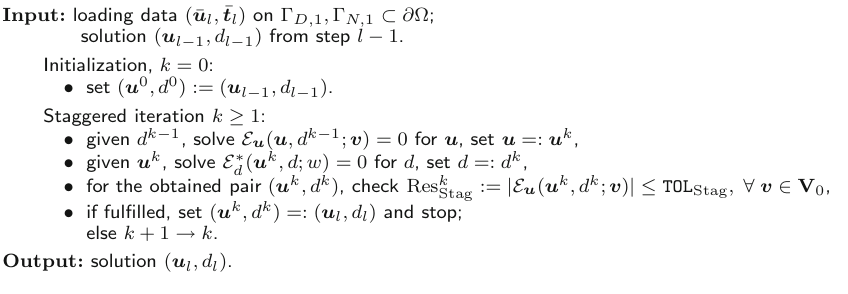
Table1 Staggered iterative solution process for (11) at a fixed loading step l Input: loading data (¯ u l , ¯ t l ) on Γ D, solution ( u l − 1 ,d l − 1 ) from step l − 1 . Initialization, k = 0 : • set ( u 0 ,d 0 ) := ( u l −